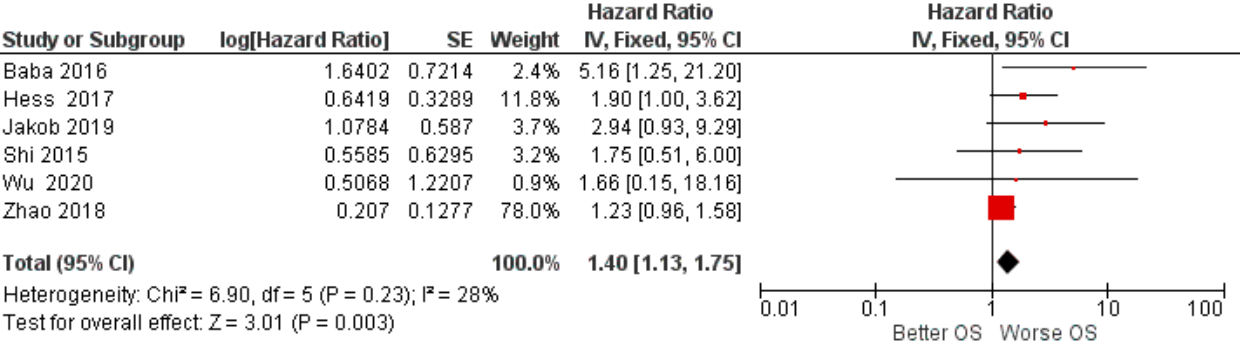
Figure 2. Forest plot of the fixed effects model of the meta-analysis; OS, HR = 1.40, 95% CI: [1.13, 1.75]; df = degrees of freedom; I 2 = Higgins heterogeneity index, I 2 < 50%, heterogeneity irrelevant; I 2 > 75%, significant heterogeneity; C.I. = confidence intervals; p = p value; SE = standard error. The graph for each study shows, the lead author and the date of publication, the Hazard Ratio with confidence intervals, with the log HR standard error and weight of each study expressed as a percentage. The final value is expressed in bold with the relative confidence intervals. The black line shows the position of the average value, and the rhombus in light black shows the measure of the average effect.